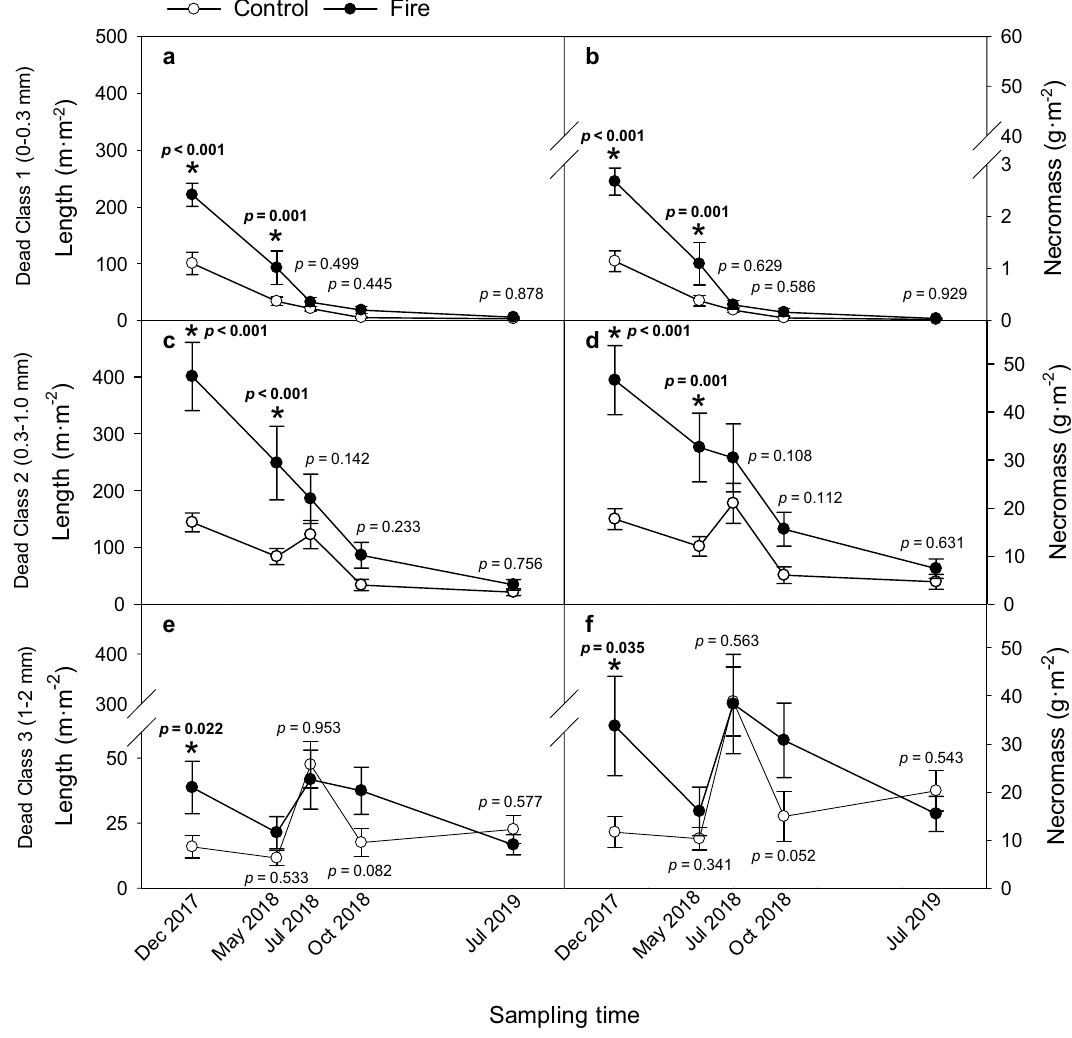
Figure 5. The significant interactions of fire × sampling time on dead fine root length (m·m −2 ) ( a , c , and e ) and standing necromass (g·m −2 ) ( b , d , and f ) for Root Class 1 (0–0.3 mm; a and b), Root Class 2 (0.3–1.0 mm; c and d), and Root Class 3 (1.0–2.0 mm; e and f). For control ( ○ ; n = 8) and fire-affected ( ● ; n = 6) trees, significant differences ( p < 0.05) determined by paired t-test and shown in bold with an